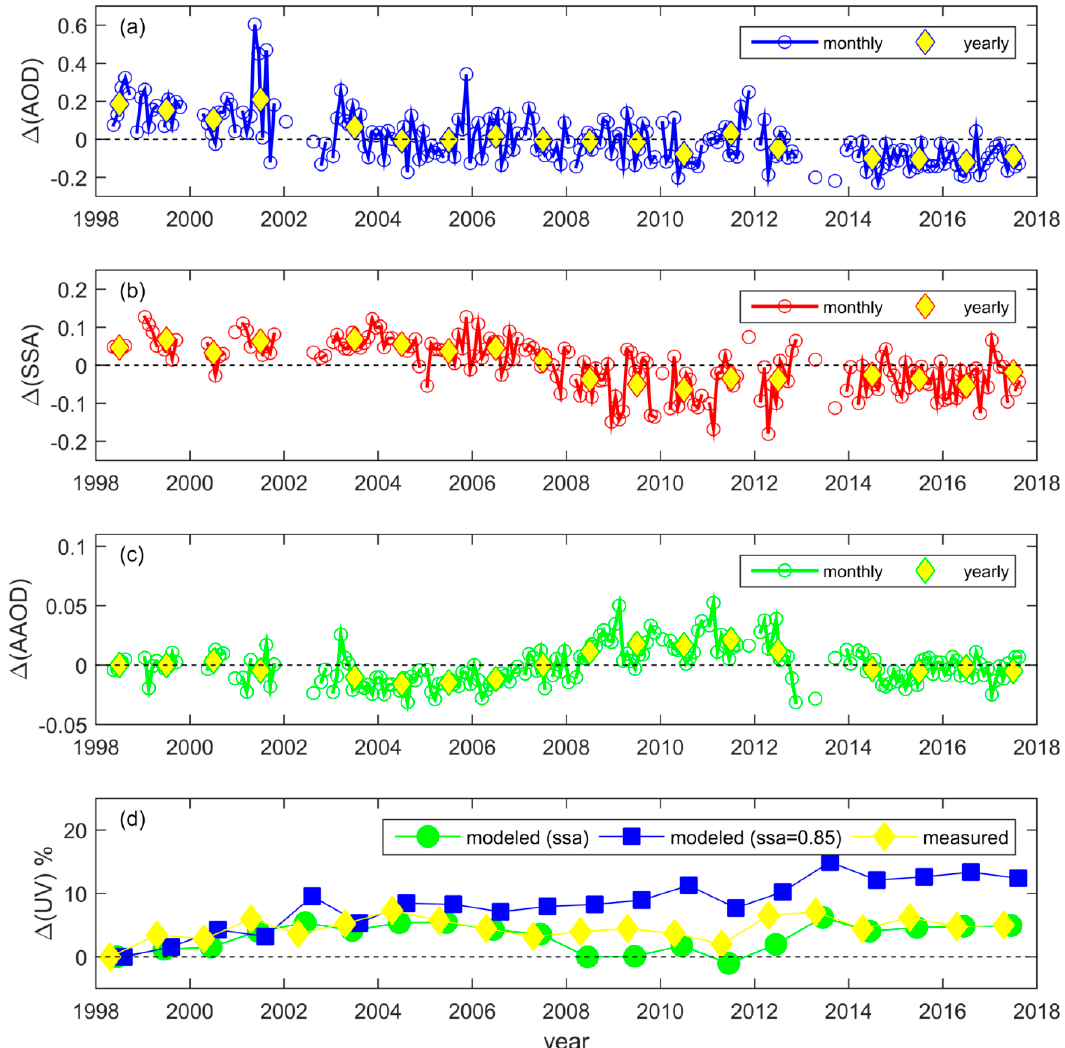
Figure 6. Monthly and annual mean anomalies for ( a ) AOD, ( b ) SSA, and ( c ) AAOD at 320 nm. Panel ( d ) depicts the di ff erence of the annual average anomalies of the global UV irradiance at 320 nm relative to 1998 from the measurements (yellow), as well as from the simulations using the measured SSA (green) and a default SSA of 0.85